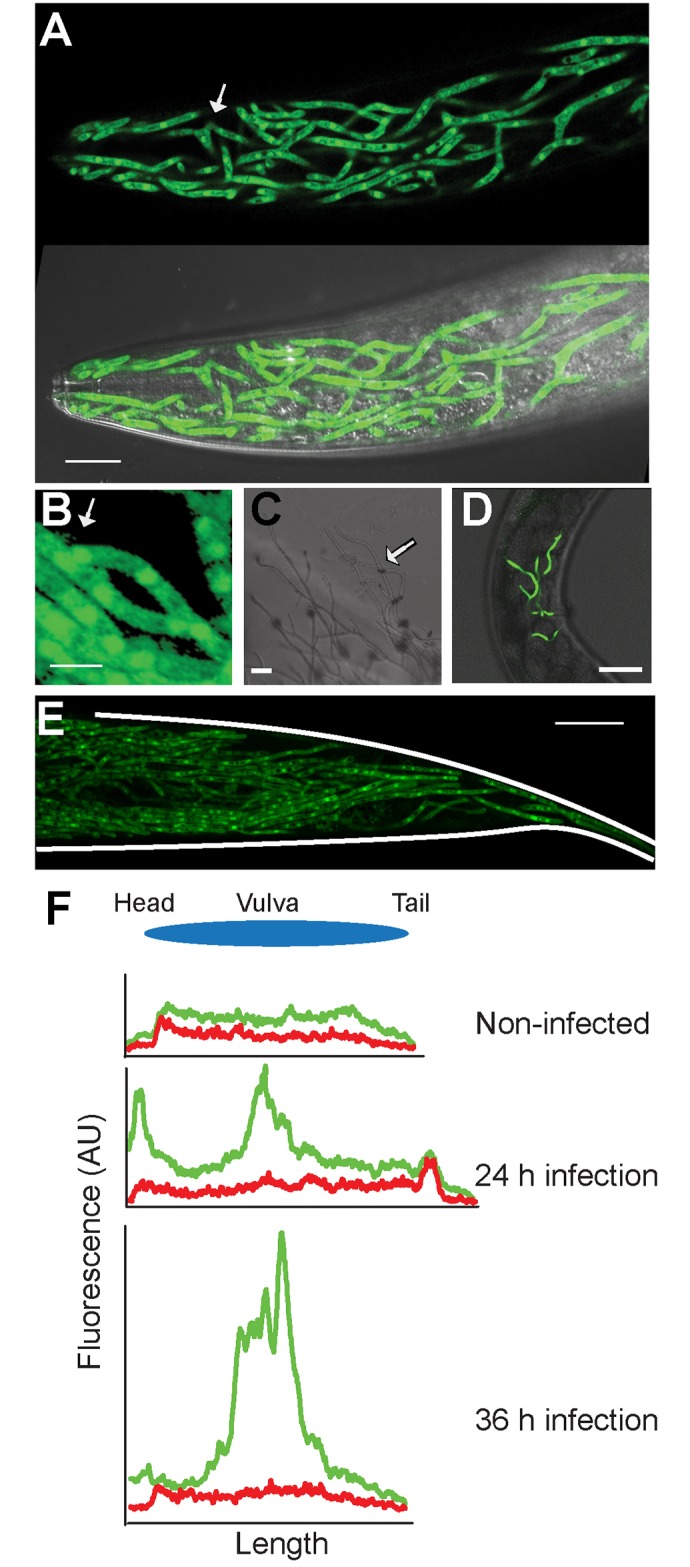
Transformation of D. coniospora.(A) A recombinant strain of D. coniospora, expressing GFP under the control of a ß-tubulin promoter, viewed by fluorescence microscopy (upper panel) combined with differential interference contrast microscopy (lower panel; scale bar, 20 μm). The fusion of 2 mycelia is highlighted by an arrow. (B) Higher magnification view of fused mycelia (scale bar, 5 μm). (C-E) The Dso mutant has a defect in anastomosis. (C) As highlighted with the arrow, in culture, mycelia are seen to grow across one another but never fuse. The mutant strain was engineered to express GFP constitutively. Fungal mycelia growing in living animals, visualized using a stereo fluorescence dissecting microscope (D), or confocal fluorescence microscope (E; the shape of the worm is traced by white lines), were not observed to fuse. Worms had been infected overnight (D) or for 60 h (A, B, E) before images were taken. Scale bars in C, D, E: 20, 50, 40 μm. (F) The growth of the fungus can also be followed using the Profiler of the COPAS Biosort. The graphs show fluorescence profiles for green and red channels for an uninfected worm (top); a worm infected at the head and vulva (peak in green signal on the left and in the middle, respectively in the middle graph) and analysed after 24 h; another worm infected at the vulva (peak in green signal in the middle, bottom graph) and analysed after 36 h. Fluorescence and length are measured in arbitrary but constant units.